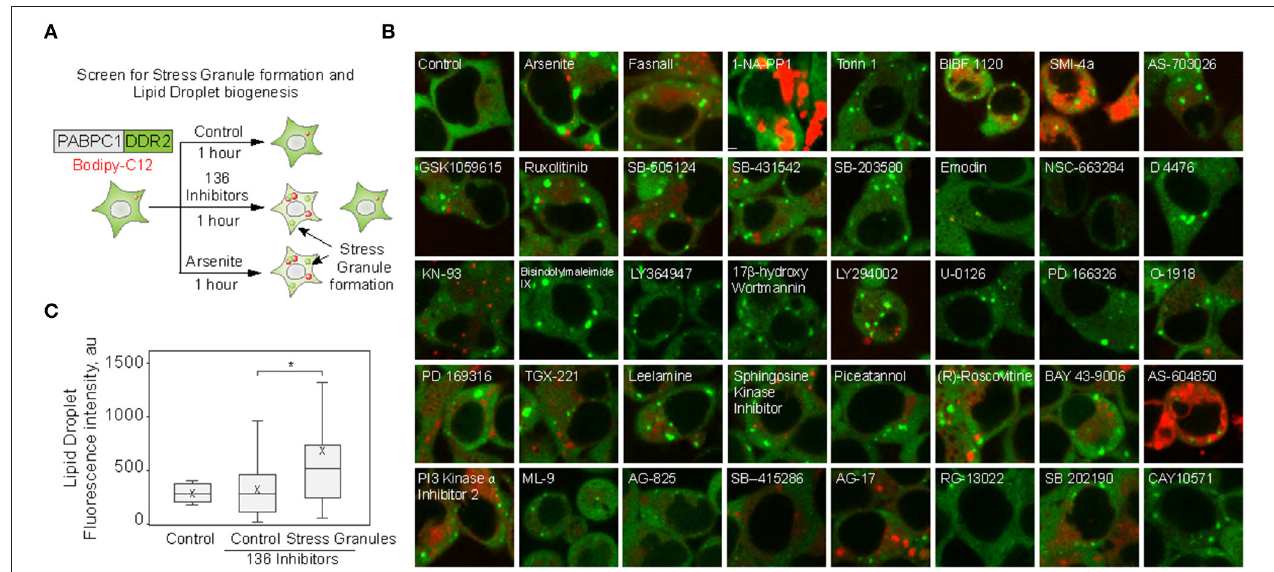
FIGURE 1 | Small molecule screen identifies the correlation between stress granule and lipid droplet formation. (A–C) Inhibitor screen for fatty acid accumulation and SG formation. Cells expressing PABPC1-DDR2 were seeded on a 96-well glass-bottom plates and grown to 80–90% confluency. One hundred thirty-six inhibitors (100 µ M) were added to the media for 1h, LD dye (Bodipy-C12, Red, 1 µ M) was added 30min prior to the experiment. Cells were visualized by confocal microscopy; inclusion formation and LD accumulation were assessed. Quantification (C) shows fluorescence intensity in lipid droplets, box indicate 25–75 percentiles, cross indicates mean, whiskers are 9–91 percentiles, for control sample (no inhibitors added), control screen samples (samples without inclusions, n = 98), stress granule samples (samples with inclusions, n = 38). Representative confocal images of the samples with inclusions are shown (B) ; refer to Supplementary Figure 1 for extended screen results. * p <